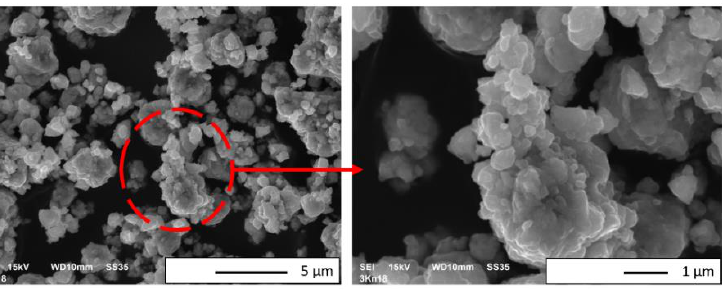
Figure 7. SEM micrographs of the NiAl + 30 wt.% Al 2 O 3 powder after mechanical alloying for 18 h.